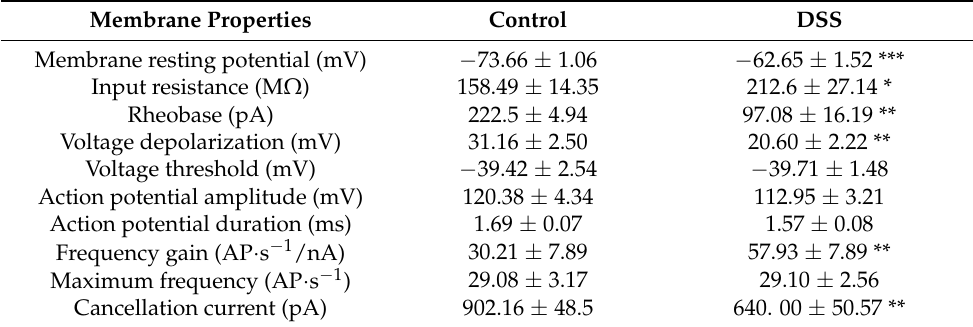
Table 1. Effects of DSS-induced acute colon inflammation on electrophysiological properties of pyramidal neurons from the primary motor cortex. Membrane Properties